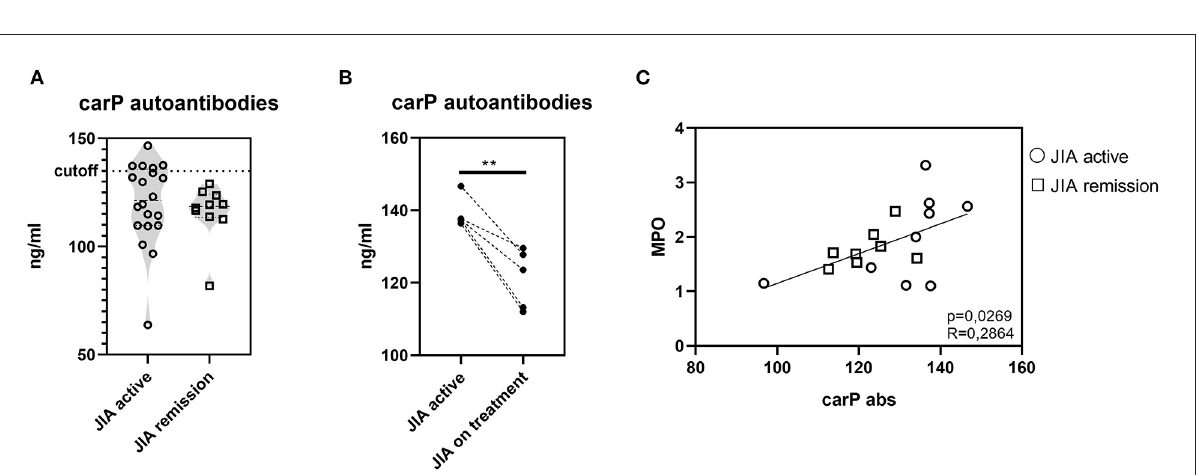
FIGURE6 Carbamylation in JIA. (A) Carbamylated autoantibodies in JIA active ( n = 20) and JIA remission ( n = 10) detected using ELISA. (B) Carbamylated autoantibodies in carP seropositive patients with active JIA ( n = 5) before and after three months of anti-TNF α treatment. (C) Correlation between carP autoantibodies and MPO. Values are standardized and expressed as median values. Statistical analyses were performed using paired t -tests. Values of p < 0.05 (*), p < 0.01 (**), p < 0.001 (***), and p < 0.0001 (****) were considered statistically significant.